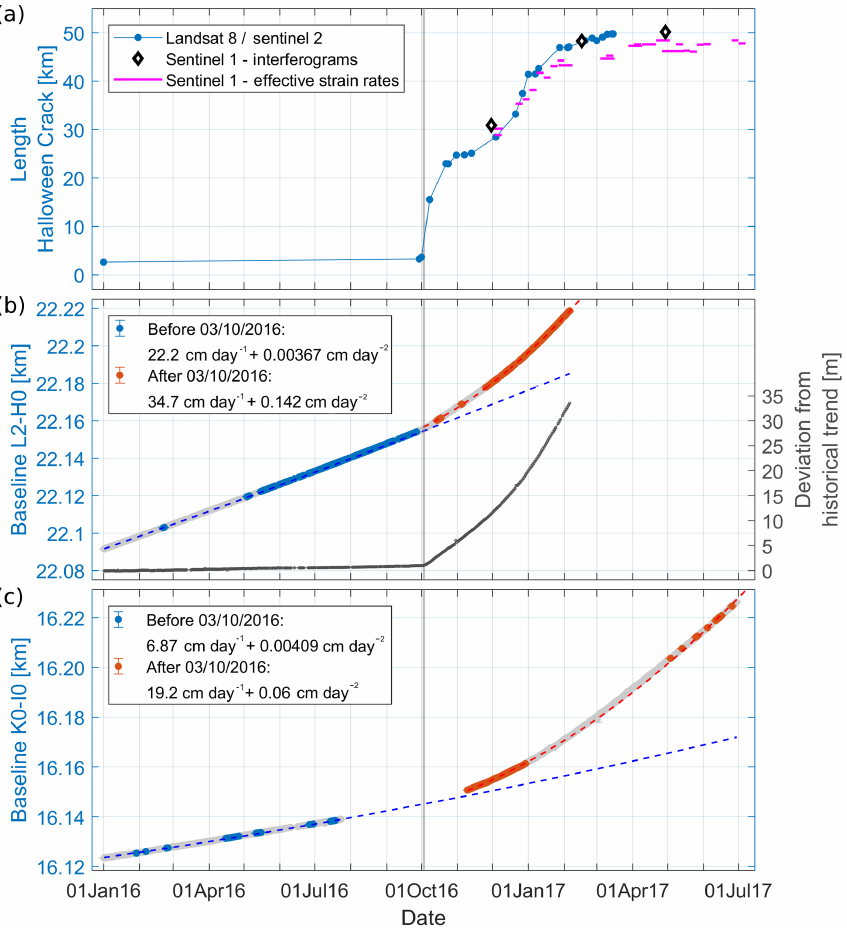
Figure 5. (a) The blue curve represents the length of Halloween Crack (HC) as a function of time based on a sequence of outlines from visible Landsat 8 and Sentinel-2 images. Black diamonds indicate the length of the HC based on manual tracking of the rift tip in a sequence of interferograms (see Fig. 6). Magenta lines correspond to the length of the HC defined as the extent of the 0.025yr − 1 contour of the effective strain rate, derived from Sentinel-1A/B velocity fields (see Fig. 7b). (b) Left axis: widening of the HC along baseline L 2– H 0 in Fig. 4; right axis (black line): deviation from the historical trend prior to the formation of the HC on 3 October 2016. (c) Same as panel (b) but for GPS stations K 0 and I 0. The grey vertical line in each image highlights the period around 3 October 2016, when the HC was